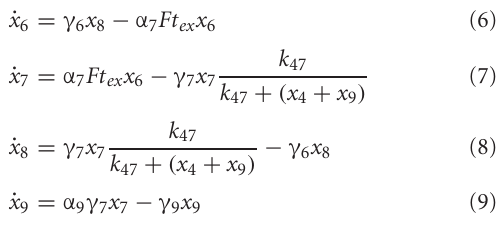
FIGURE 1 | TIM-2 pathway model of the TIM-2 receptor, endosome formation, HFt degradation, and iron release into the iron labile pool. Iron is subsequently either stored in endogenous HFt or exported to the media. Iron uptake by the TIM-2 receptor occurs at the cellular membrane.